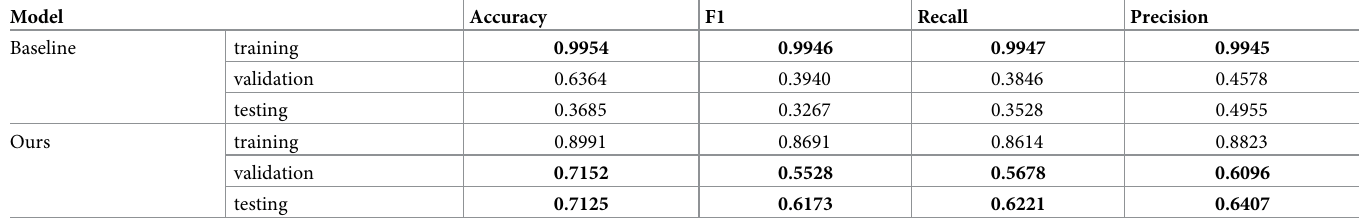
Table 6. Comparison of the two CNN-LSTM models. The baseline is ImageNet-pre-trained CNN-LSTM; ours is the factory-segmentation-pre-trained CNN-LSTM. Scores were calculated using the macro average. The highest scores are expressed in a bold font. Model